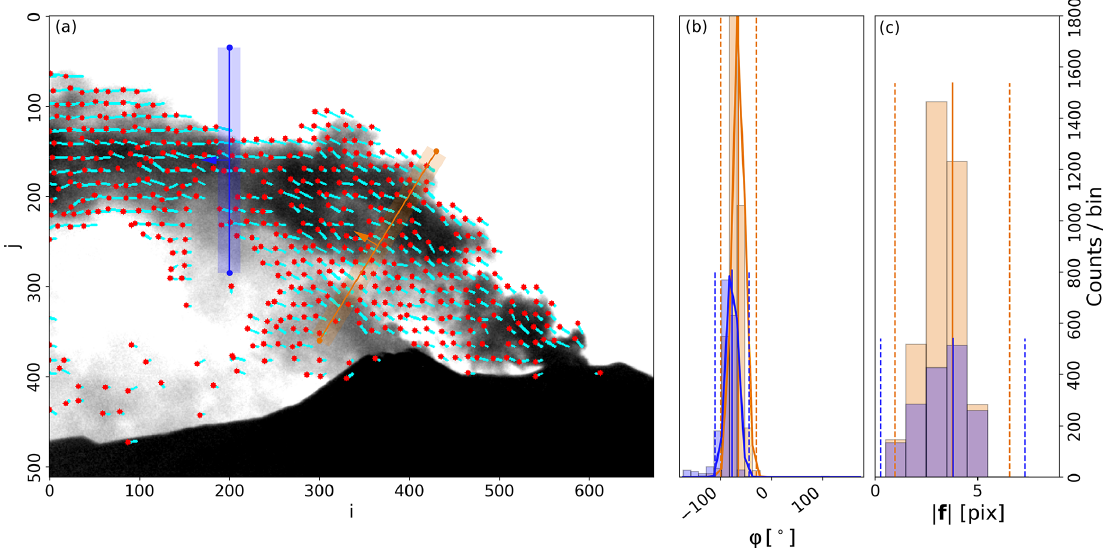
Figure 4. (a) Example flow vector field (blue lines with red dots) of the Farnebäck optical flow algorithm for the Etna plume at 07:13UTC including the two PCS lines (blue and orange) and the corresponding ROIs used for the histogram analysis (semi-transparent rectangles). Middle, right: histograms of orientation angles M ϕ and vector magnitudes M | f | for both lines (bar plot), determined using condition no. 7 in Appendix A1. The M ϕ histogram (b) also includes fit results of the multi-Gauss peak detection (thick solid lines). The retrieved histogram parameters (ϕ µ , | f | µ ) and expectation intervals M ϕ , M | f | are indicated with solid and dashed vertical lines, respectively. From the corrected DVF, average effective velocities of v eff = ( 3 . 9 ± 0 . 5 ) ms − 1 (orange line) and v eff = ( 4 . 4 ± 0 . 8 ) ms − 1 (blue line) were retrieved. Note that in the left image (1) vectors shorter than 1.5pixels are excluded, (2) the displayed vector lengths were extended by factors of 3, and (3) only every 15th pixel of the DVF is